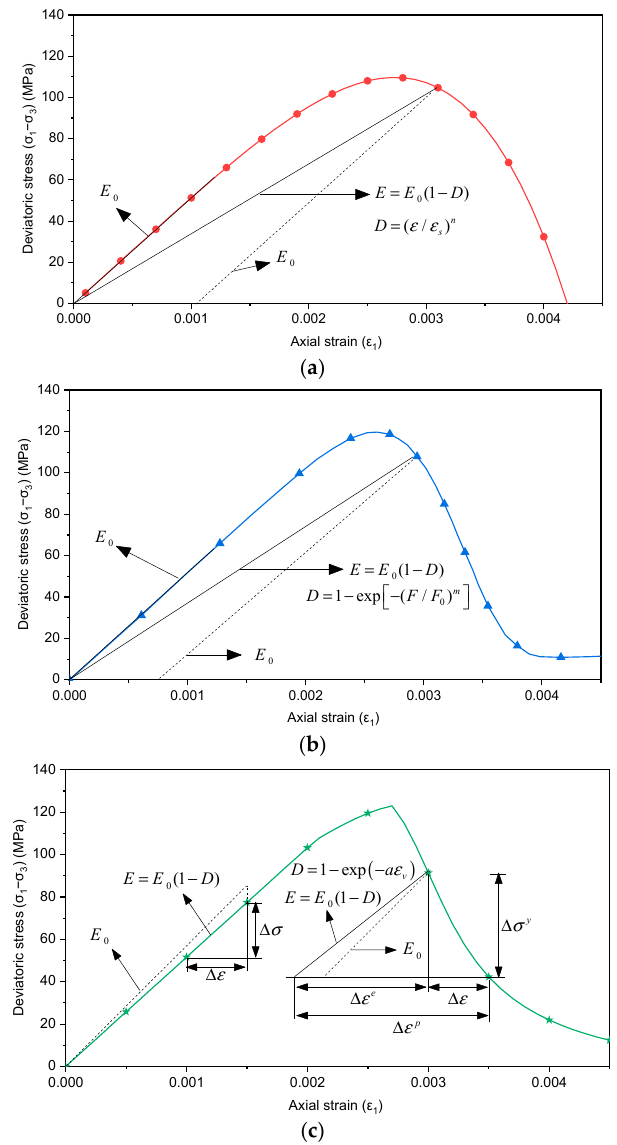
Figure 1c. The incremental method is adopted when introducing the plastic calculation. In the pre-peak stage before the plastic yield, the stress increment ∆ σ depends on the degraded elastic modulus due to damage. It decreases with the increase in damage, and thus causes the stress-strain curve to bend downward. Once a plastic yield function has been satisfied, the stress increment ∆ σ depends on the plastic hardening function and a certain plastic deformation happens. The yield stress decreases with the increase in damage, and thus a negative stress increment is obtained which causes the stress-strain curve to descend. In the classical plastic stage without damage, the total strain increment is the sum of elastic strain and plastic strain. However, in the post-peak stage after the plastic yield coupling with damage, the total strain increment is derived by subtracting elastic strain from plastic strain, i.e., ∆ ε = ∆ ε p − ∆ ε e . Although the elastic modulus is also degraded, the descent of the stress-strain curve is supposed to be caused by the reduction of yield stress. above damage models, respectively. However, such a descent of a stress-strain curve needs to be evaluated prudently. According to Equations (1)–(20), the theoretical stress- The elastic damage can only affect the steepness of such a descent slightly. Because damage strain curves can be plotted and the calculating principles of the damage effect are illus- is coupled with plastic that tracked with irreversible plastic deformation, the irreversibility trated in Figure 1. of damage can also be represented.